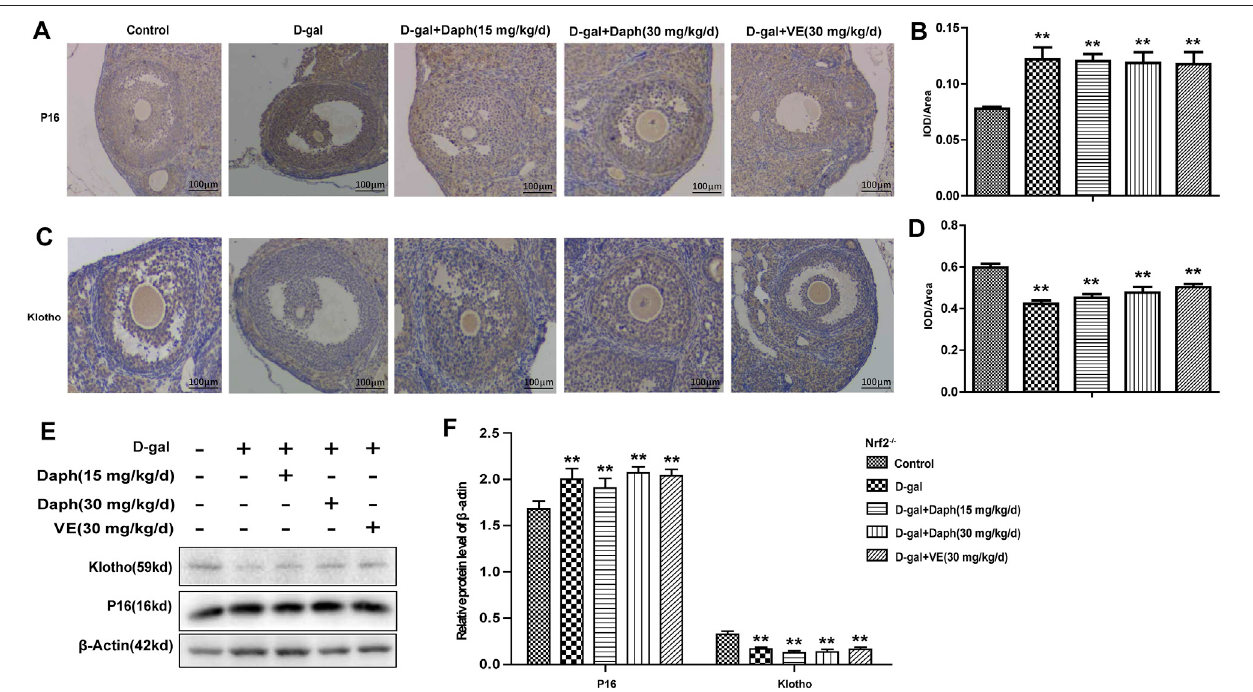
FIGURE 7 | Knockout of Nrf2 abolished the regulatory capability of Daph for ovarian senescence-associated protein expression. (A – D) The IHC staining showed thep16andklothoexpressionsinthe fi vegroupsinNrf2 − / − mice. (E,F) Expressionsofp16andklothoweremeasuredthroughwesternblot.Thedatain (A – D) areshown as means ± SEMs, n = 5. The data in (E,F) are shown as means ± SEMs, n = 3. Statistical signi fi cance: ** p <